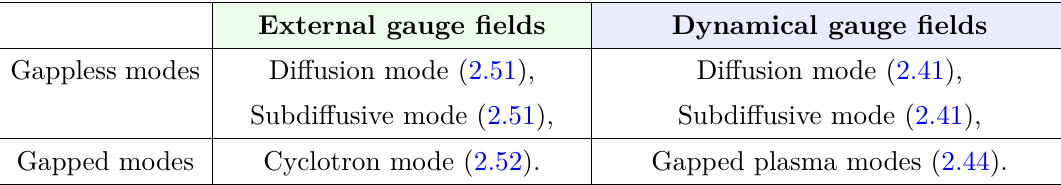
Table 2 . The low energy modes at finite density and finite magnetic